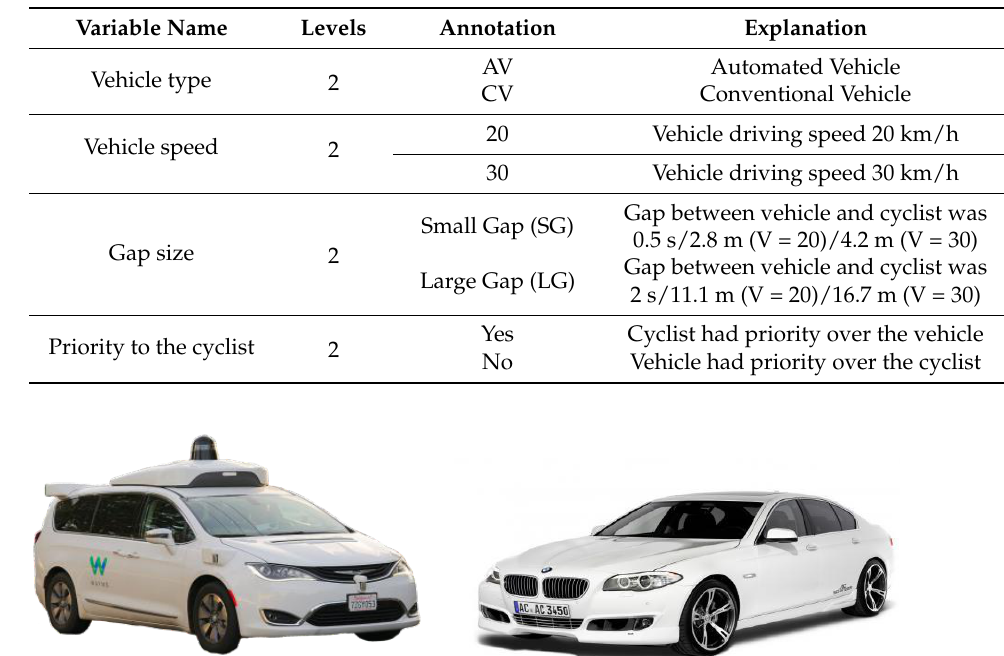
Figure 1. Appearance of automated vehicles (AV) ( left ) and conventional vehicle (CV) ( right ).